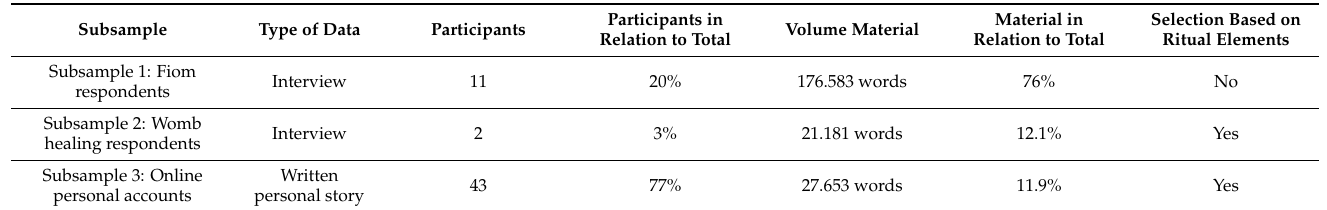
Table 1. Types of